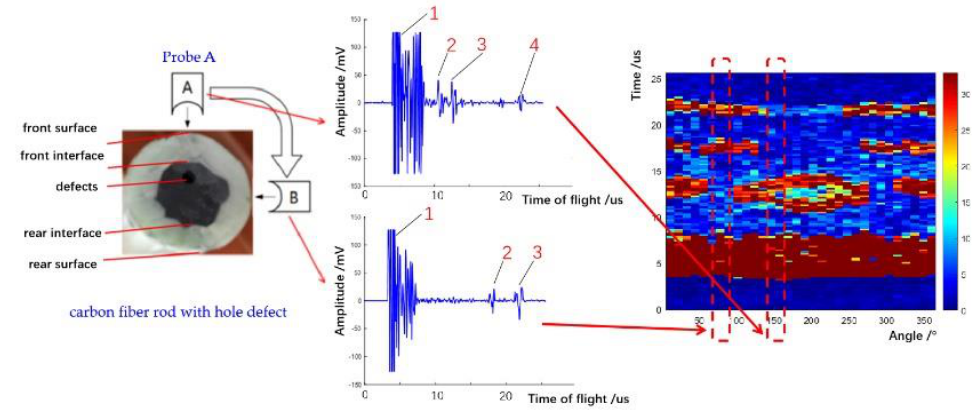
Figure 8. Multi-information fusion into an image.